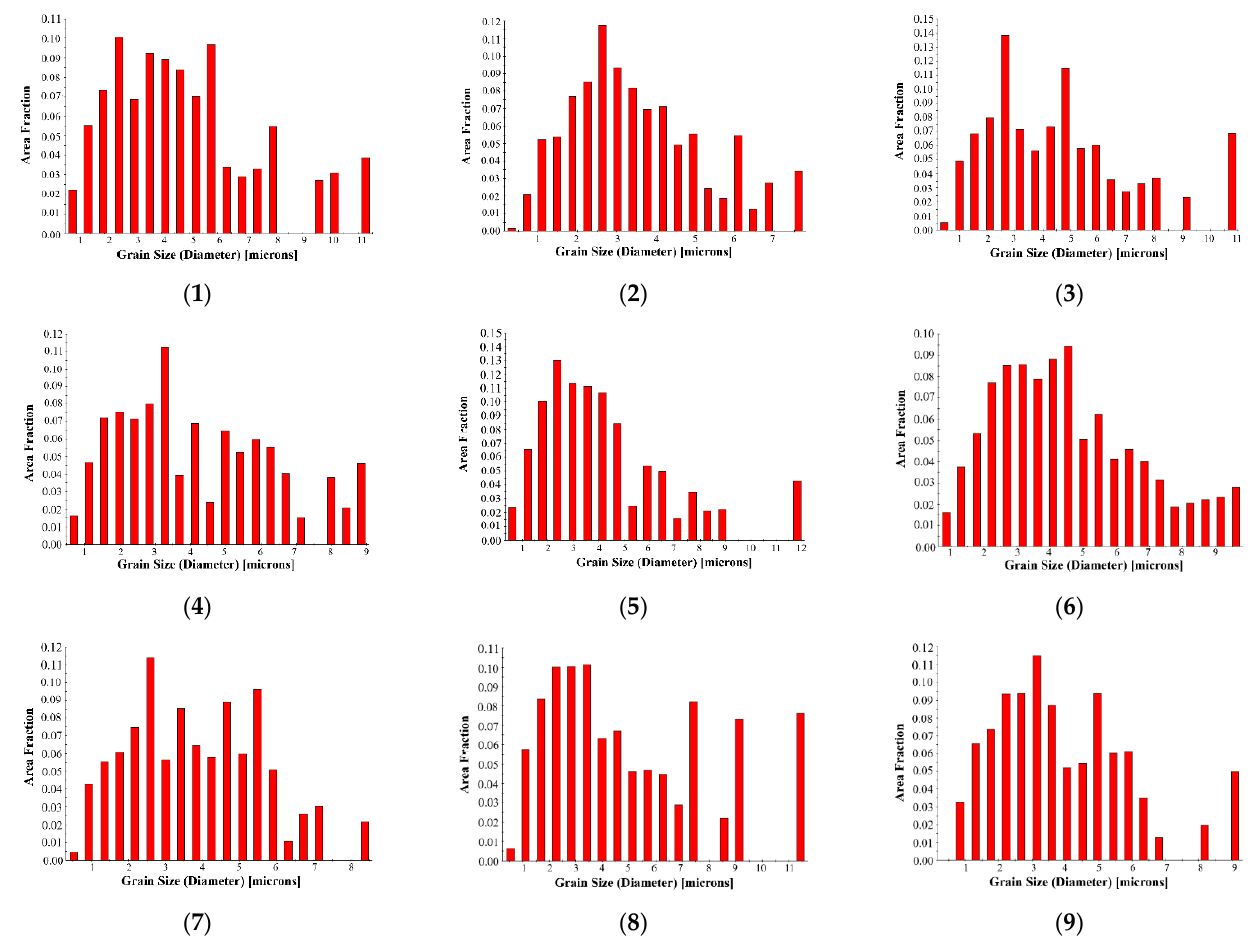
Figure 10. The grain size statistics of Ti-6Al-4V under different milling parameters.